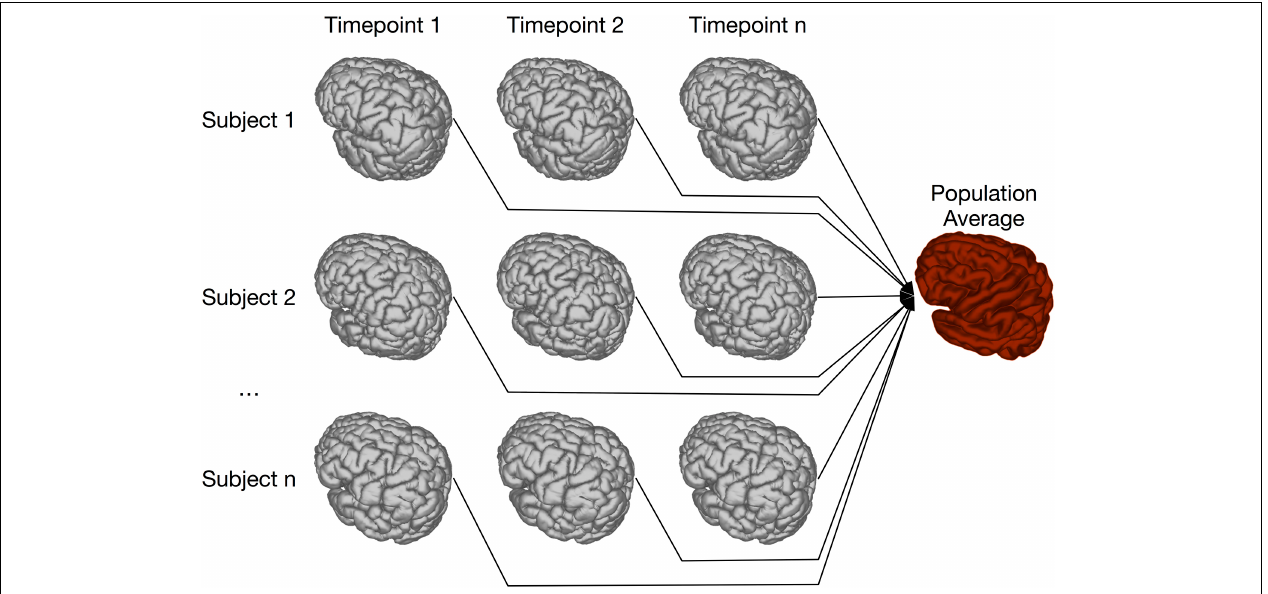
FIGURE 7 | Schematic of iterative group-wise registration. This schematic depicts a registration scenario where all subjects, each scanned at one or multiple time points, can be registered to a consensus